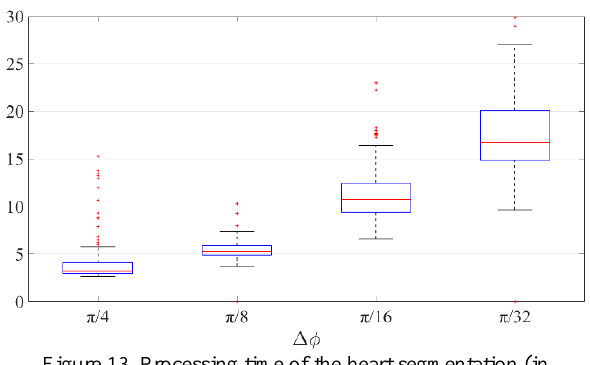
Figure 13. Processing time of the heart segmentation (in milliseconds) of the proposed algorithm for different ∆φ